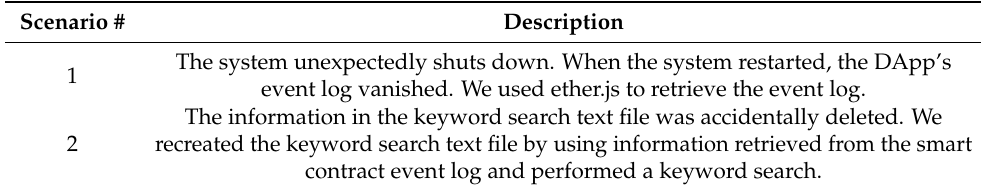
Table 3. Performance Evaluation Scenario